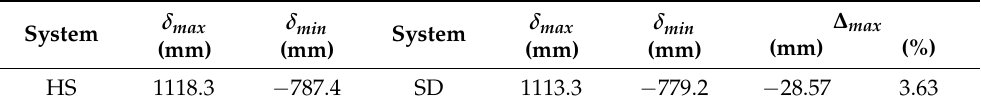
Table 8. Measurement difference between high-speed (HS) system and standalone DSLR (SD) system in assessing high-amplitude seismic excitation.